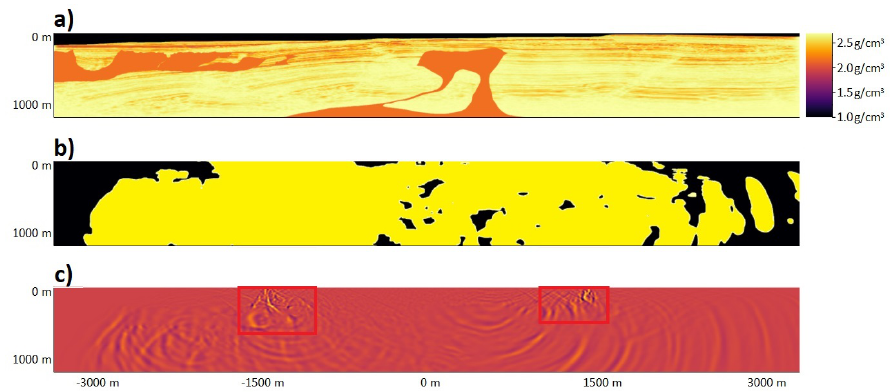
Figure 5. ( a ) The density model from [22]. ( b ) The map of relevant grid points at the final subinterval of the simulation with parameter θ set to 0.7. ( c ) The wavefield at the end of the standard FDM simulation with the strong waves marked with red